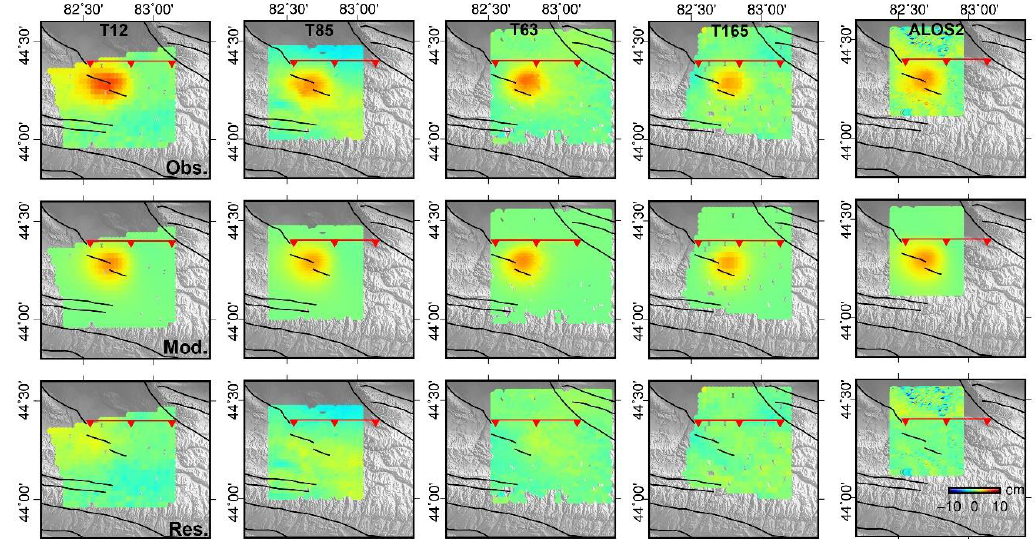
Figure 8. Quad-tree down-sampled observations (Obs., first line) for each track-orbit, forward modeling results (Mod., second line), and residual (Res., last line) inversion of the south dipping model. From left to right, the results are based on data from T12, T85, T63, T165, and the Advanced Land Observing Satellite2 (ALOS2). All subplots share the color scale shown in the lower right of the